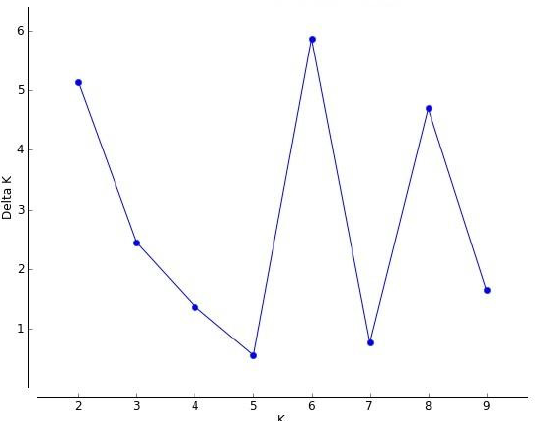
Figure 5. A plot of posterior probability for a given value of K vs. associated standard deviation ( ∆ K ) to determine the optimal number of clusters representing the complete genome data of Indian SARS-CoV-2 isolates.